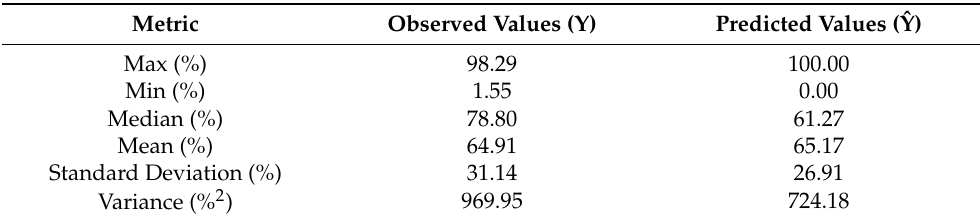
Figure 7. Plot of predicted vs. observed recoveries from the 5-component regression model. Samples are sorted according to ascending observed values to better reflect residual distances; predictions clearly improve in the middle to upper recovery ranges. Table 3. Comparison of summary statistics for observed and predicted bitumen recoveries from PLS regression model (5 components).